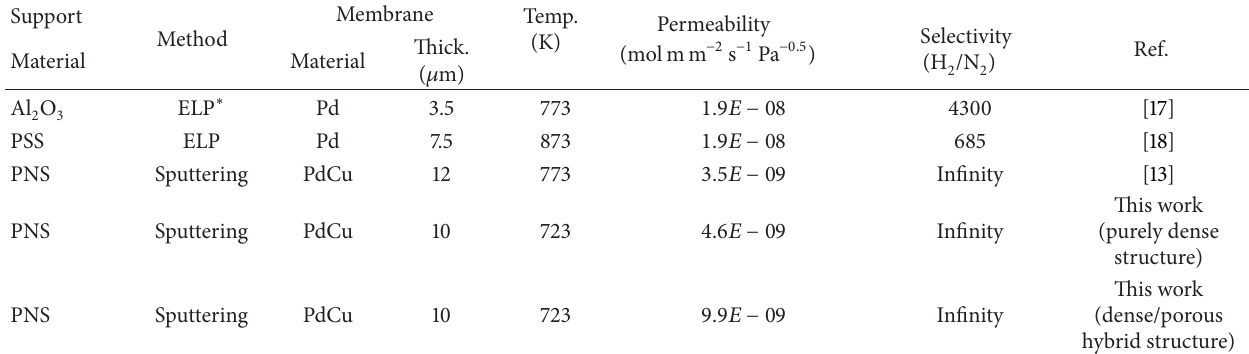
∗ ELP: electroless